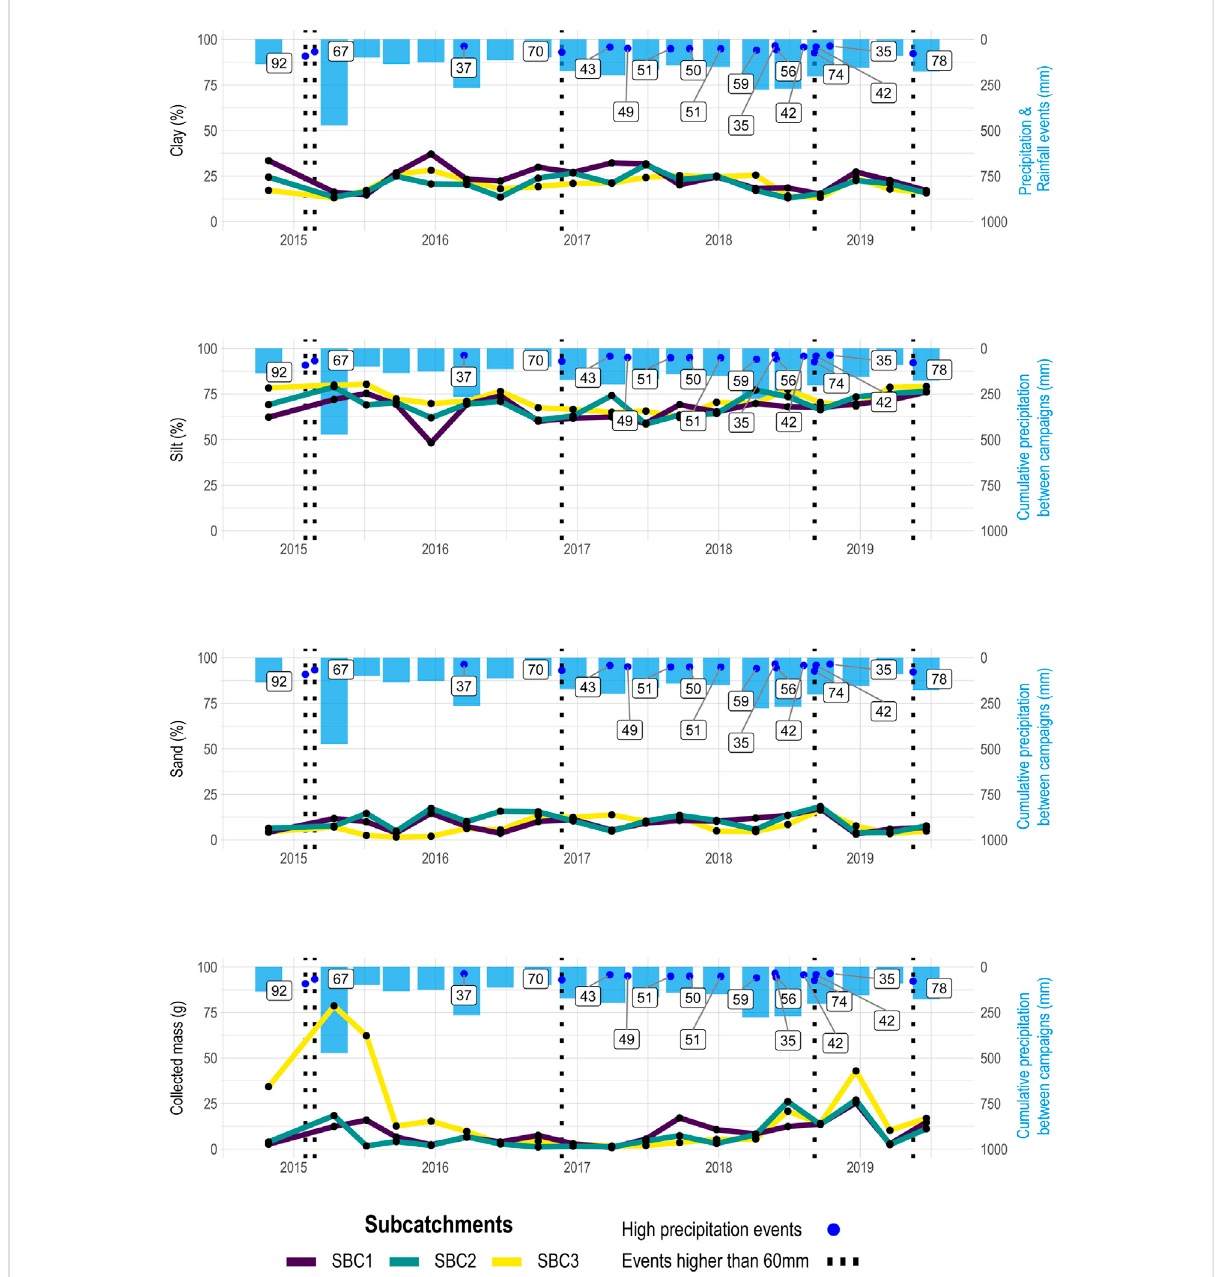
FIGURE 7 Temporal trends of the mean/median values of the different particle sizes, clay, silt, and sand and the collected mass in the three sub- catchments (SBC1, SBC2, and SBC3). Vertical black dashed lines highlight rainfall events higher than 60 mm. Blue dots represent high rainfall events with the labels of mm of